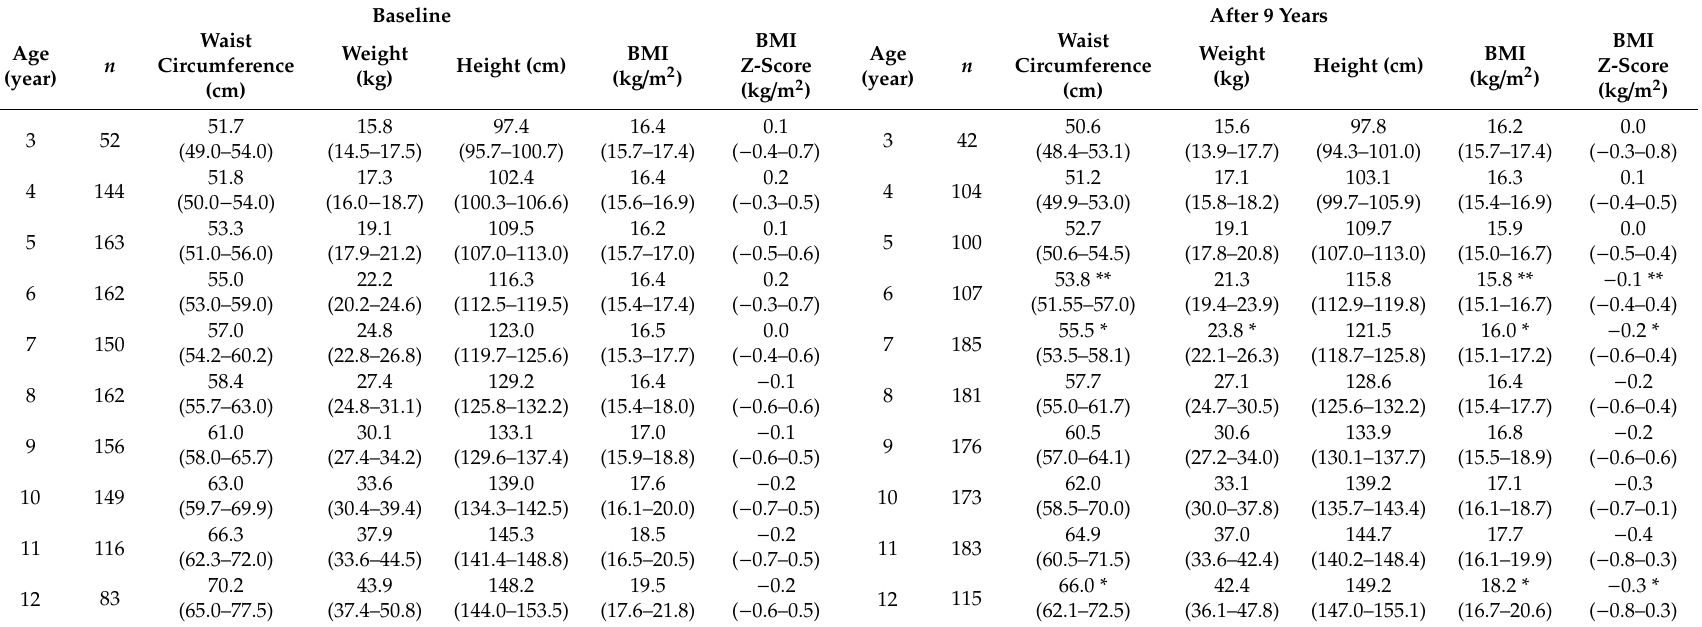
Table 2. Anthropometric variables in boys at baseline and after 9